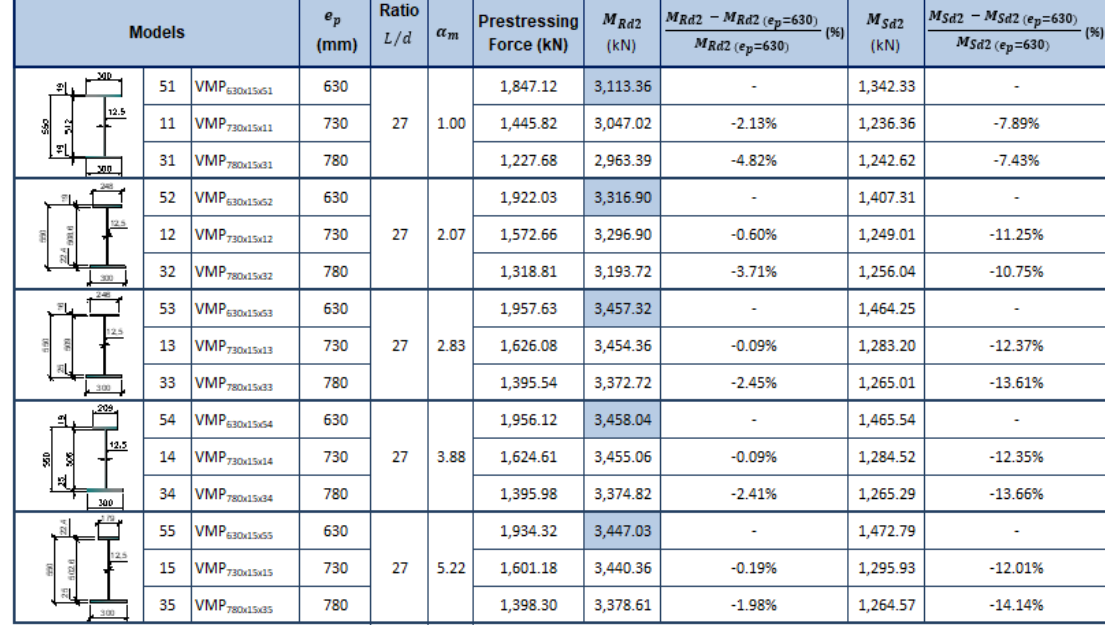
Figure 13. Eccentricity influence - / L d ratio = 27.